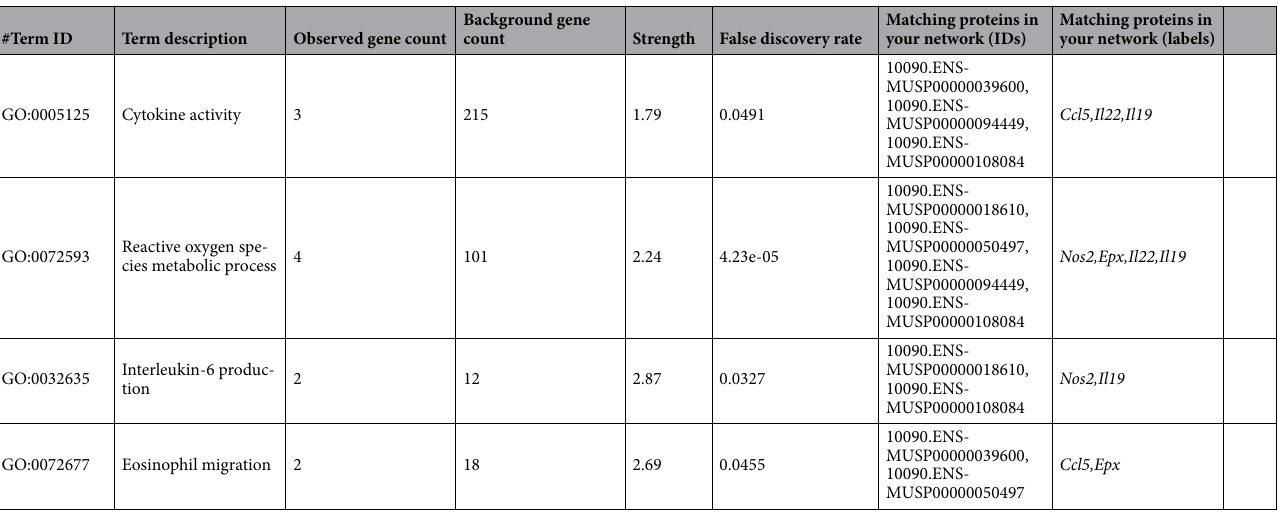
Table 3. Function and process pathway analysis by using the GO data base of cluster